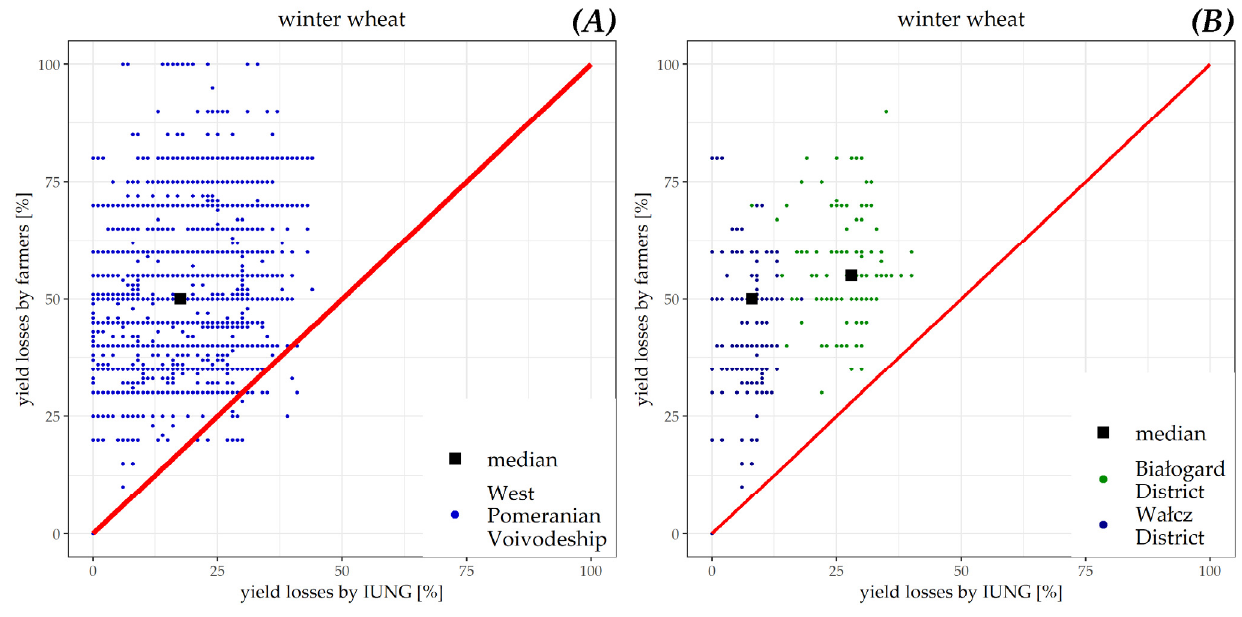
Figure 5. ( A ) Comparison of farmers’ declarations with the ADMS results for losses incurred in fields with winter wheat cultivation—in the West Pomeranian Voivodeship. ( B ) Comparison of farmers’ declarations with the ADMS results for losses incurred in fields with winter wheat cultivation in the following districts: Bia ł ogard (the most severe drought in the West Pomeranian Voivodeship) and Wa ł cz (the least severe drought). Source: own study (IUNG-PIB).